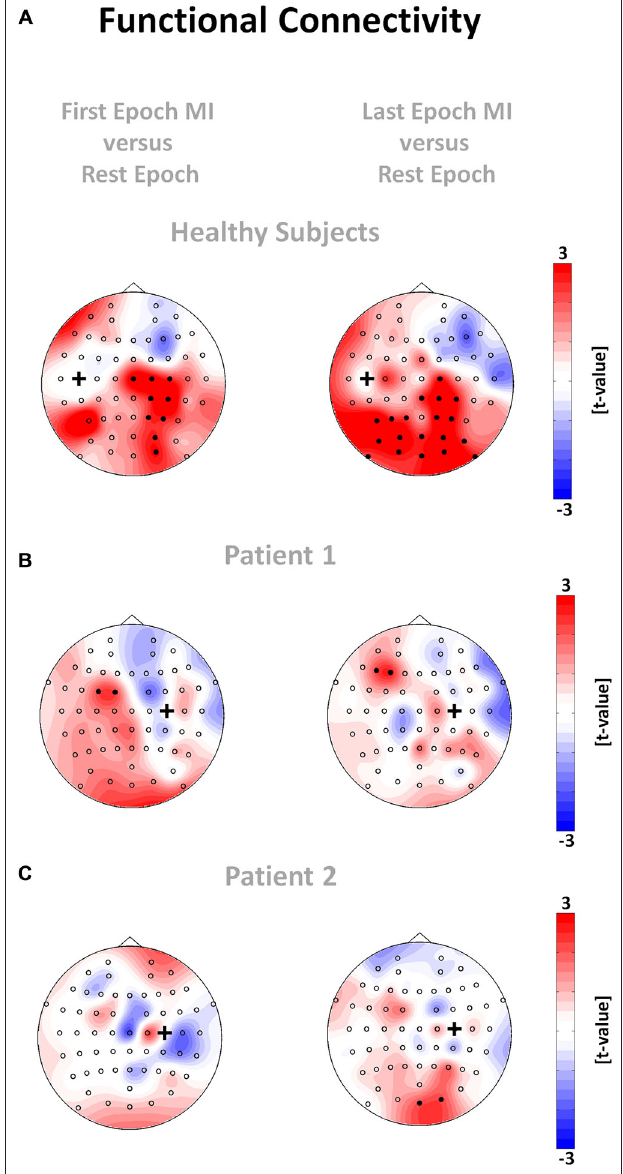
FIGURE 6 | Functional connectivity networks for healthy subjects (A) and patient 1 (B) and 2 (C). The plots show the t-value topographies of functional connectivity (absolute value of ciCOH) as a contrast between the two MI epochs and the rest epoch for the θ -band. The black cross indicates the seed electrode position. Electrode clusters, showing significant differences in the non-parametric randomization test, are indicated by filled black circles. Colors indicate functional connectivity increases (red) and decreases (blue) within the MI epoch relative to the rest